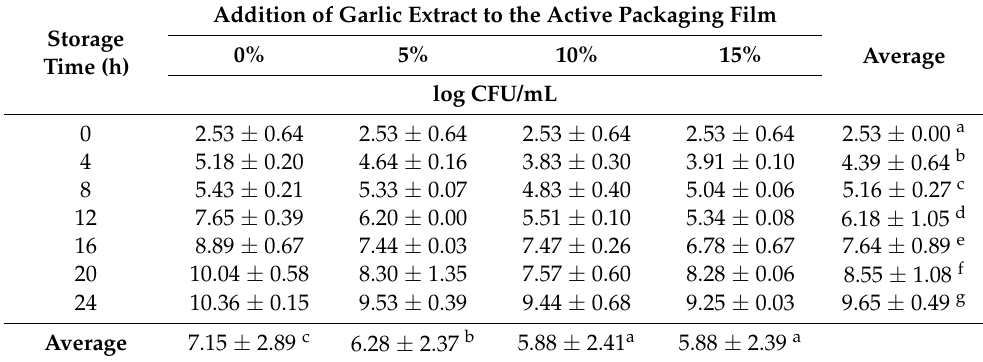
Table 3. Total plate count (TPC) of packed meat stored at room temperature for 24